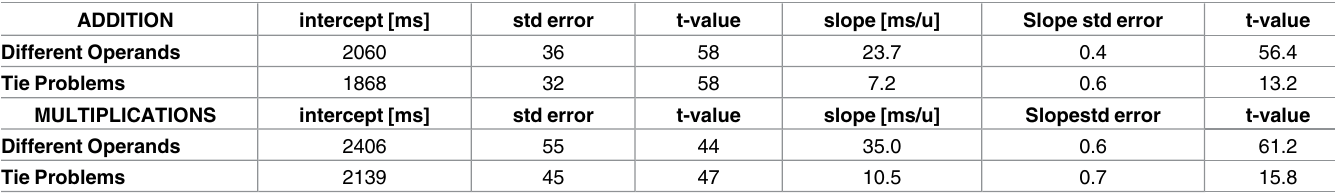
Table 1. Results of the mixed model linear regressions for RTs using the product of the operands as independent variable.